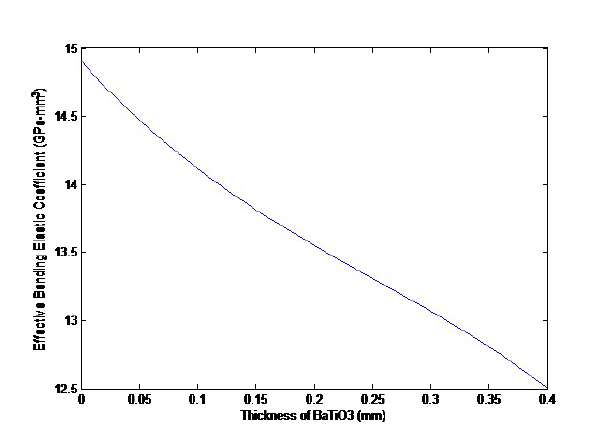
⟨ ⟩ bending coeflcient vs. thick- zb (1)22 22